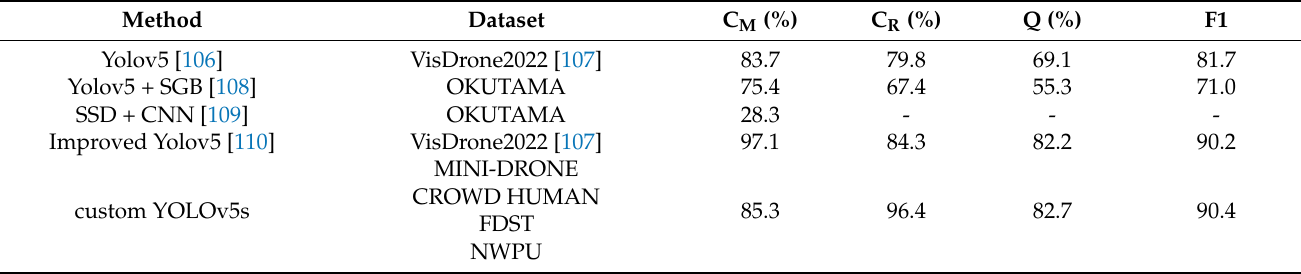
Table 9. Comparison between the custom YOLOv5s with other studies that adopt YOLOv5 or other detectors focused in person detection from high-altitude and UAV camera